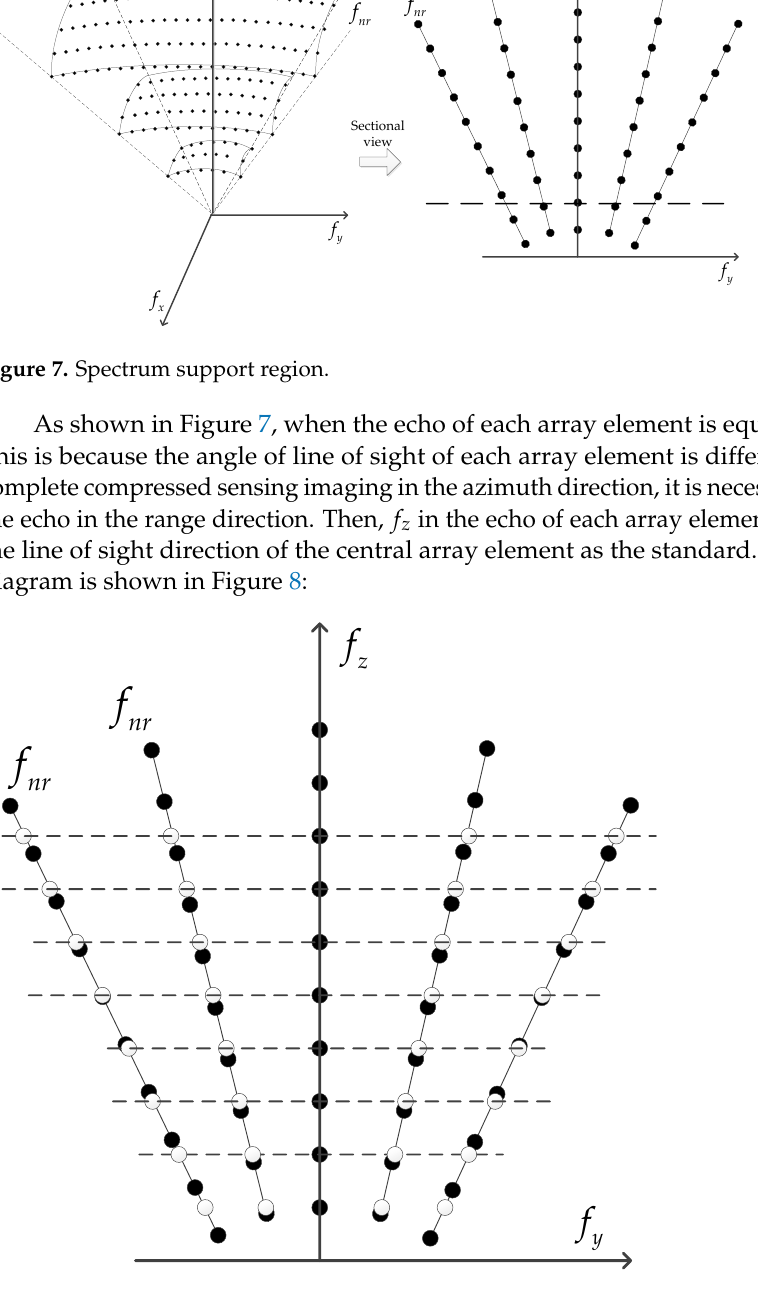
Figure 2. Interpolation diagram. Figure 8. Interpolation